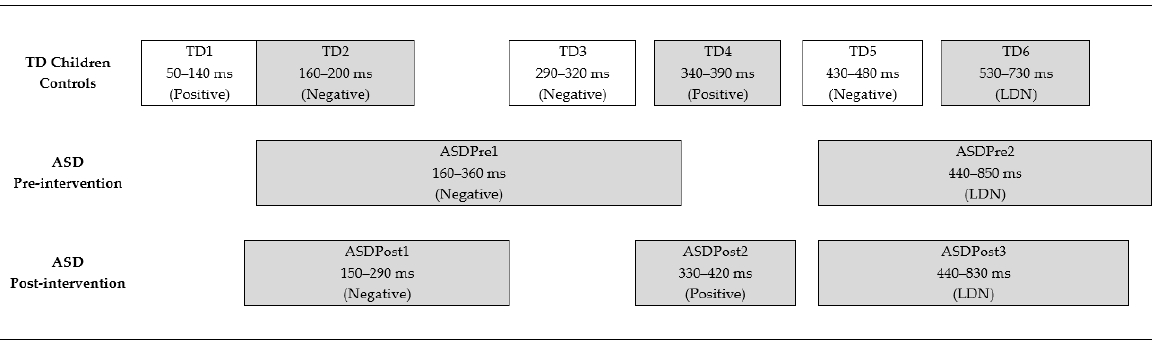
Figure 4. Timeline presentation of mismatch windows for each participant group, derived by conducting single t -tests at each time point of group average emotion- combined difference waveforms, and identifying contiguous periods of significant deviance from 0 μ V.